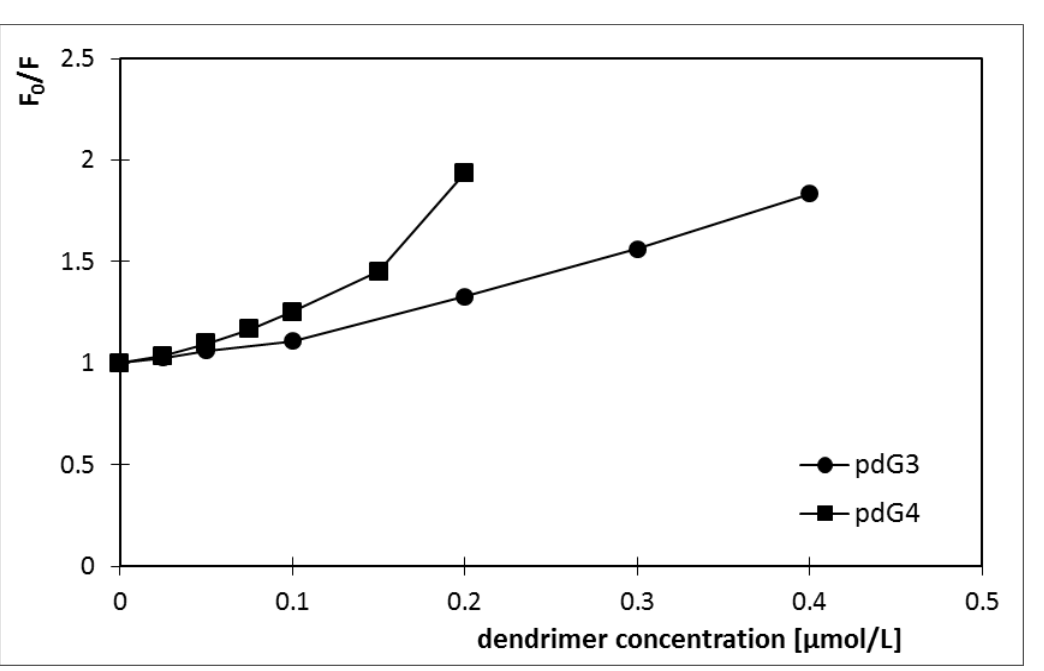
Figure 4. Stern-Volmer plots for ethidium bromide fluorescence quenching by phosphorus dendrimers generation 3 (pdG3) and 4